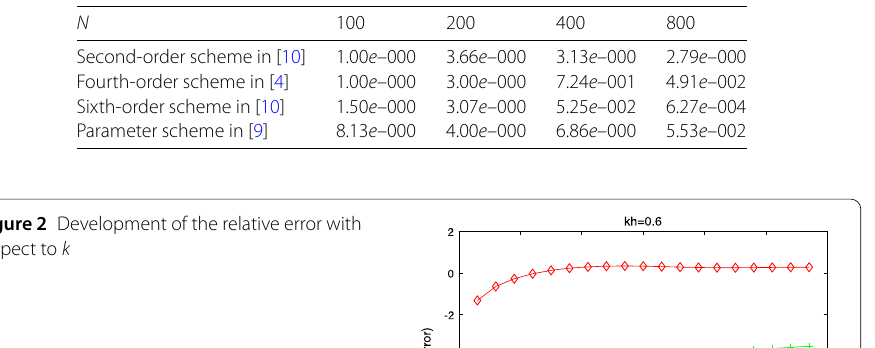
Table 6 Errors of different schemes ( k = 500)